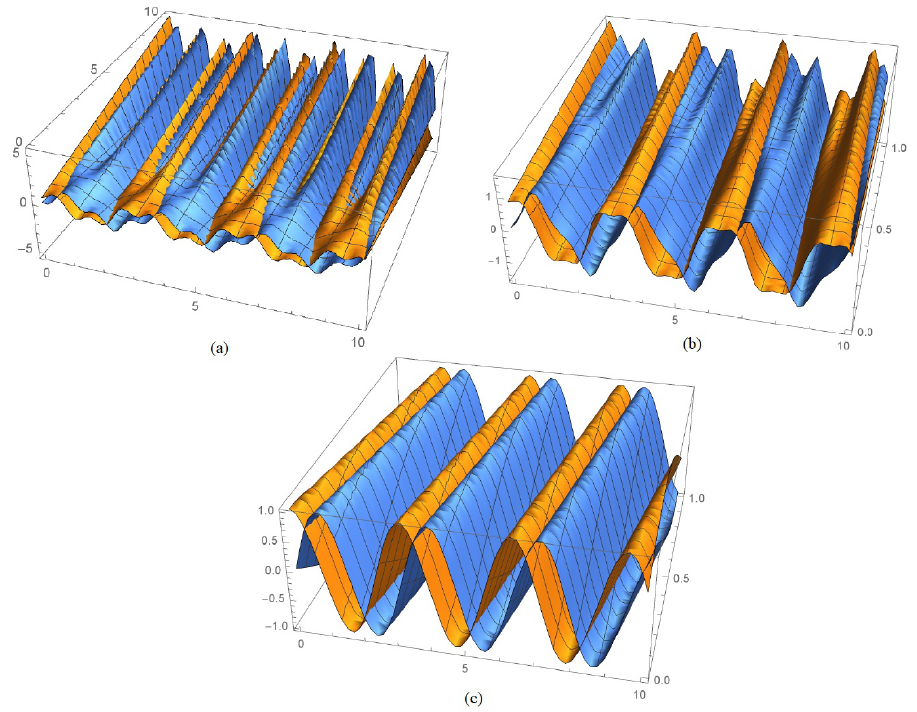
Figure 5. Three dimensional (3D) display of X ( ϕ , t ) for α = 0.5—( a ), α = 0.8—( b ) and the exact solution—( c